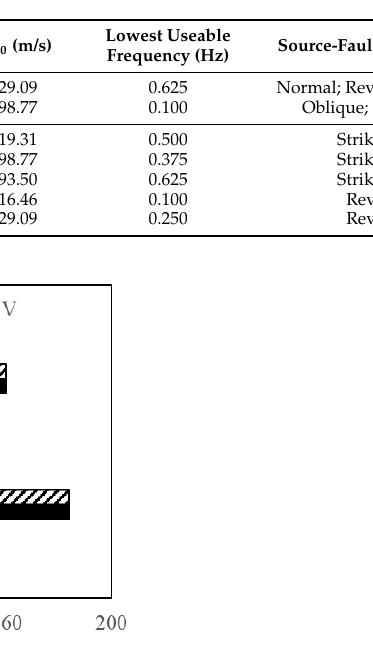
Figure 14. Acceleration of a four-story structure obtained from ANN and NLTHA for five EQs. Figure 15. MIDR of a four-story structure obtained from ANN and NLTHA for five EQs. Similarly, the ANN model is also tested on a three-story mass irregularity structure. The earthquakes, this time, consisted of design-based EQs (DBE) and maximum consid- ered EQs (MCE) to achieve meaningful results and to compare them with the results